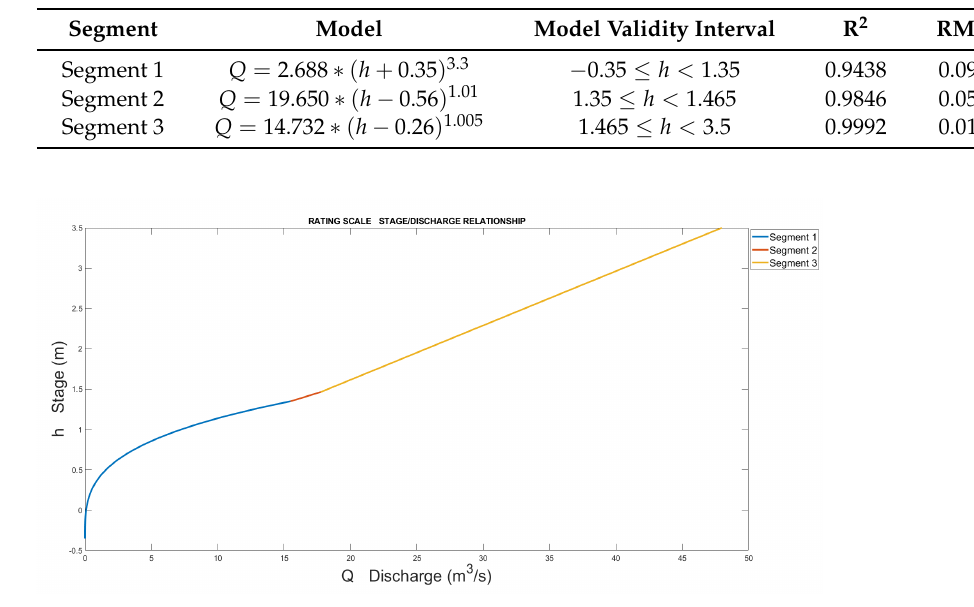
Figure 16. Rating scale of Nera with the 3 segments.